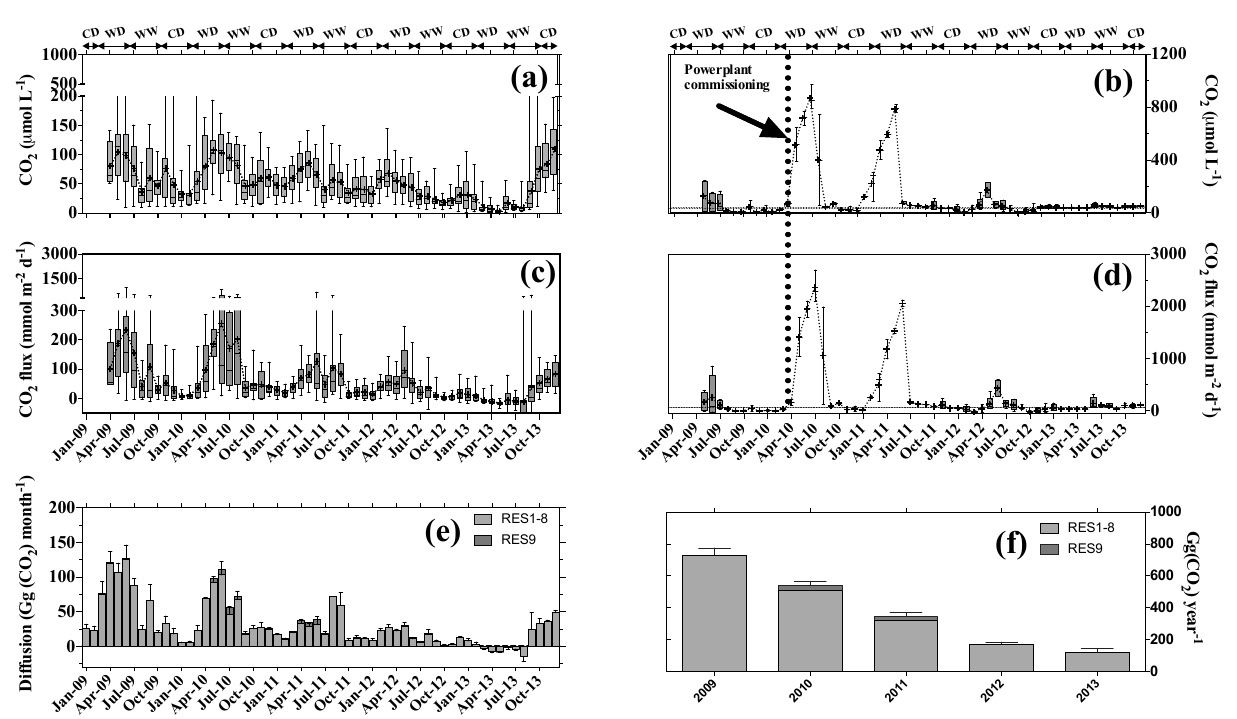
Figure 5. Monthly average CO 2 concentrations at the stations RES1–8 (a) and at the station RES9 (b) , average diffusive fluxes at the stations RES1–8 (c) and at the station RES9 (d) and total monthly (e) and yearly (f) CO 2 emissions by diffusive fluxes from the Nam Theun 2 Reservoir (Lao